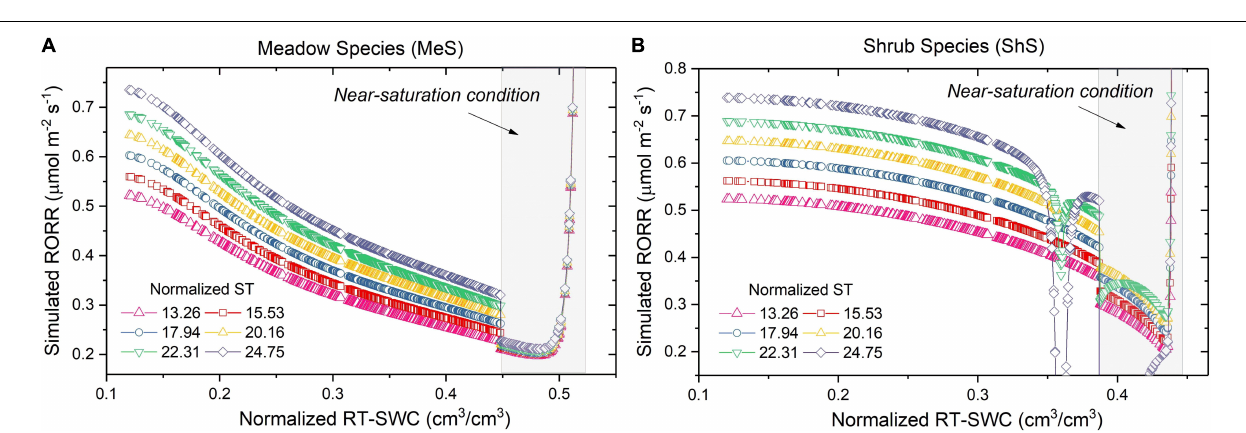
then visualized by using linear regression methods.